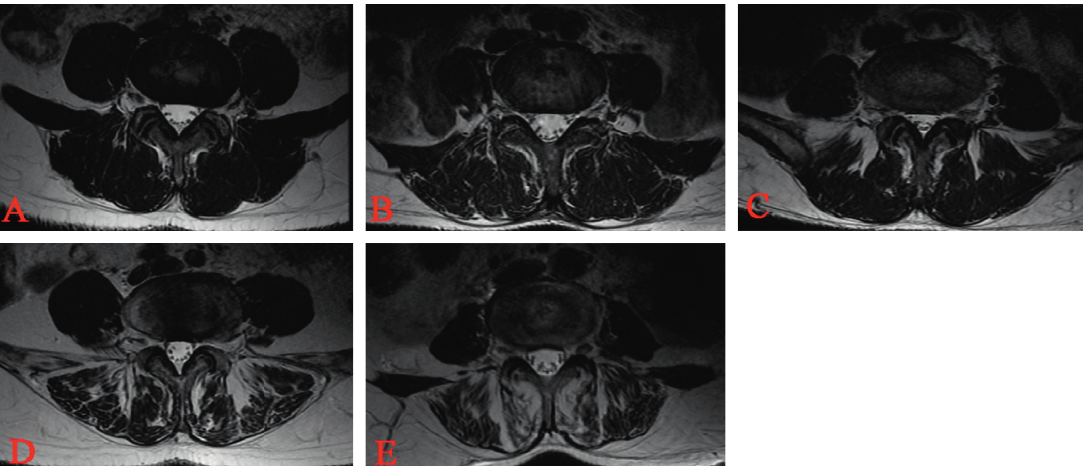
Figure 5: Goutallier grades 0 to 4 on T1W axial MRIs. (a) Grade 0, normal, almost no fat infiltration. (b) Grade 1, fatty streaks within the muscle. (c) Grade 2, fat infiltration was less than muscle mass. (d) Grade 3, fat infiltration was approximately equal to muscle mass. (e) Grade 4, fat infiltration was greater than muscle mass. Two experienced spine surgeons independently applied the Goutallier grades to the paraspinal muscle. Surgeons graded the paraspinal muscle for fat content at L4/5 levels on T1W MR axial images.